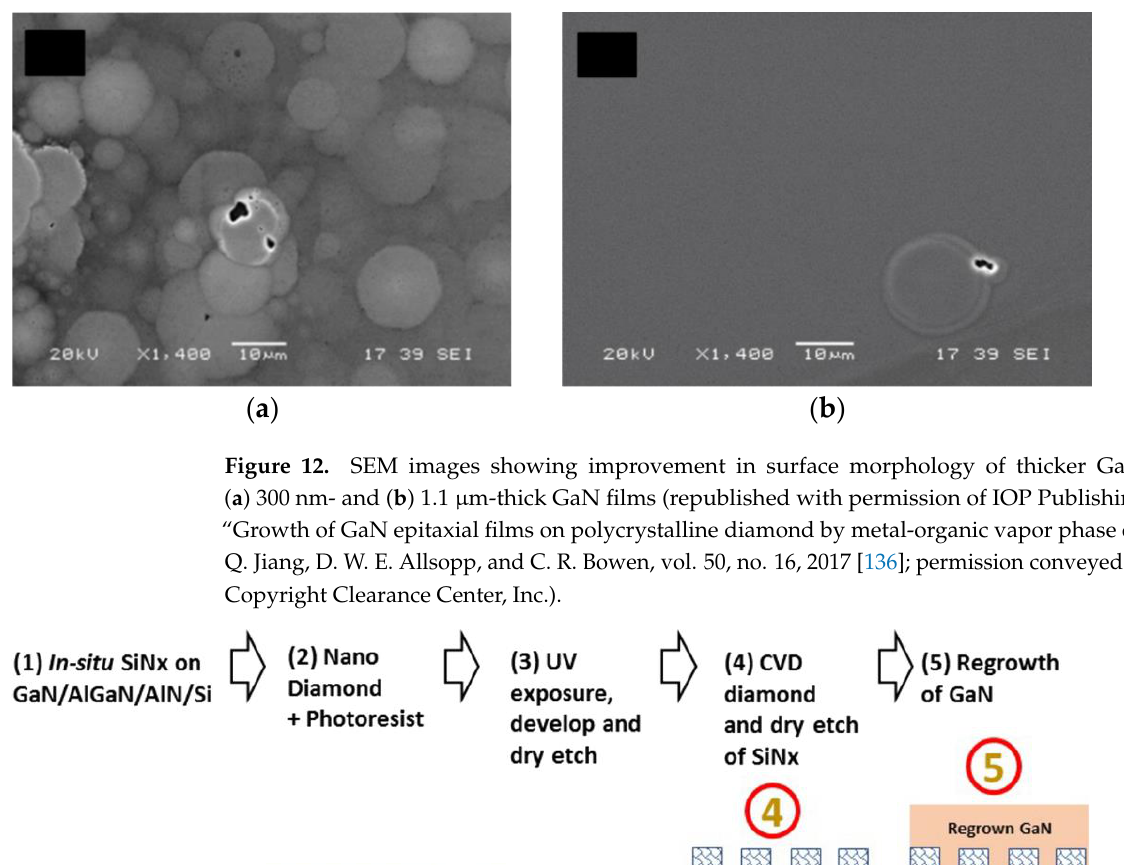
( b ) Figure 11. ( a ) SEM image of masked and ELO growth of GaN. ( b ) TEM image showing original and ELO growth of GaN; arrows indicate boundary between original (right of boundary) and ELO (left of boundary) growth (reprinted from [124]; permission conveyed through CCBY 3.0). Later the team proposed a different approach [136]; the (111) Si substrate from com- mercial diamond-on-Si substrates was etched, exposing the back surface of the PCD sub- strate that was shown to feature a thin Si x C layer formed during the deposition of the PCD on the Si substrate. According to the authors, this Si x C layer provides sufficient crystallo- graphic information for the epitaxial growth process to occur. Following the etching of the Si substrate, the PCD films exhibited some curvature, due to the thermal stress caused by the high diamond deposition temperatures and the difference in the CTE s of both materi- als. AlN or Al 0.75 Ga 0.25 N nucleation layers were grown on the SiC layer and GaN was de- posited by MOVPE. Interestingly, the growth on the nucleation surface of the curved di- amond substrate was shown to effectively remove the surface defects induced by the non- single crystalline nature of the Si x C layer and to reduce the tensile stress induced by the